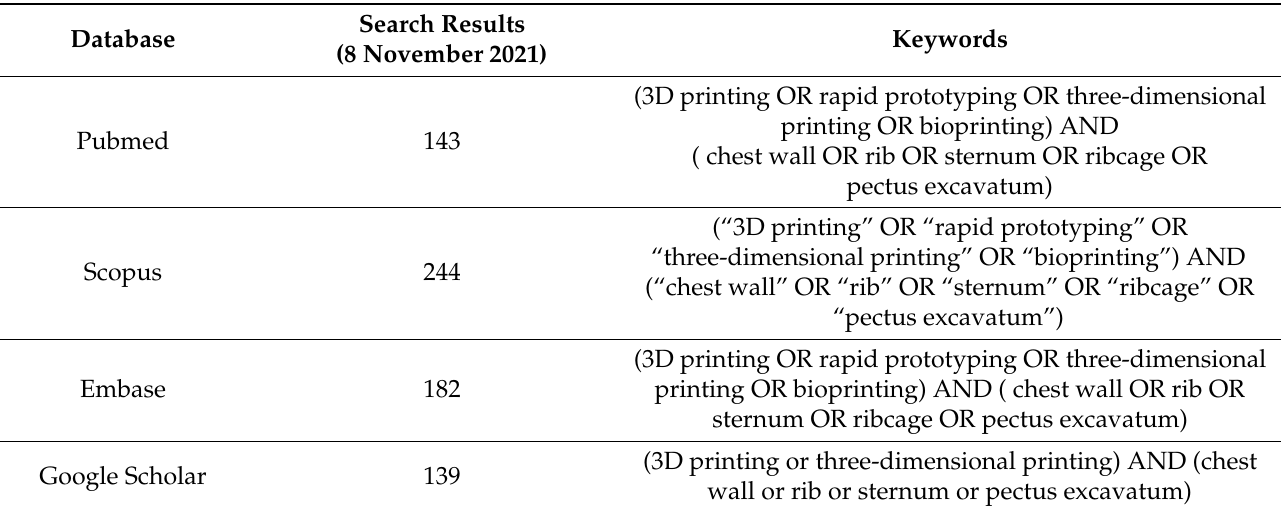
Table 1. Details of the database search.